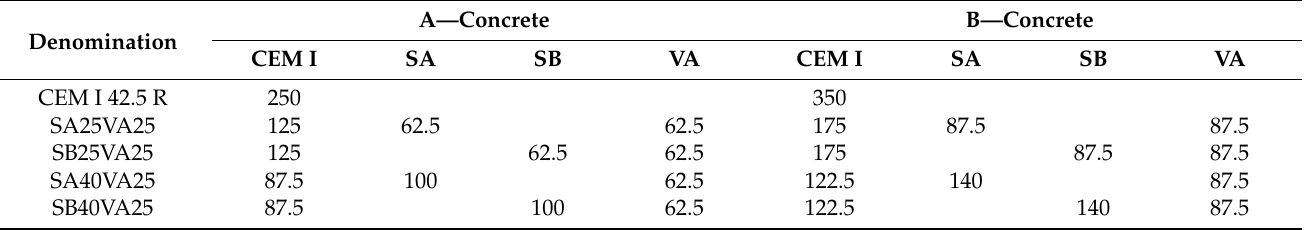
Table 4. Cement constituents for each concrete, i.e., A and B (kg/m 3